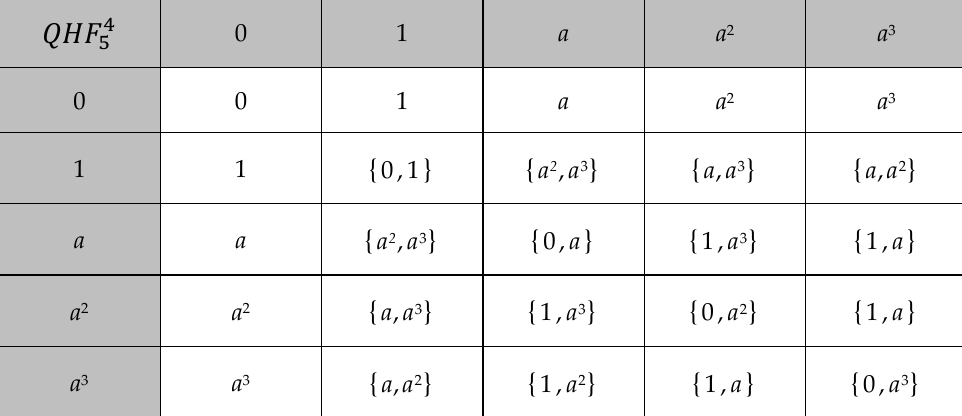
Table 16. The Cayley table of the additive canonical hypergroup of the quotient hyperfield GF [3 2 ]/G, which is also denoted by 𝑄𝐻𝐹 54 .